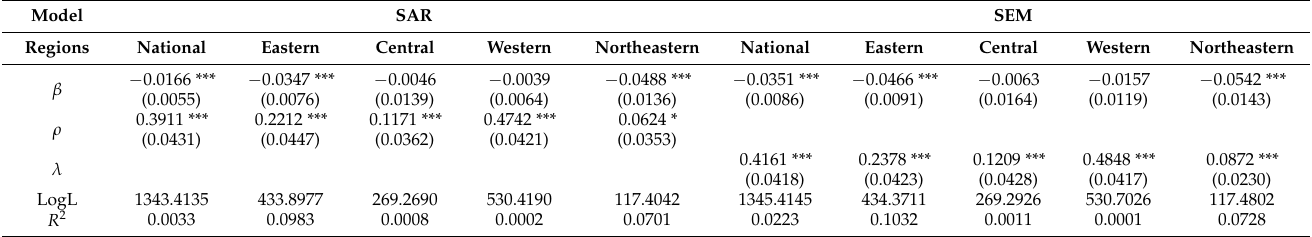
Table 4. Results of absolute β -convergence